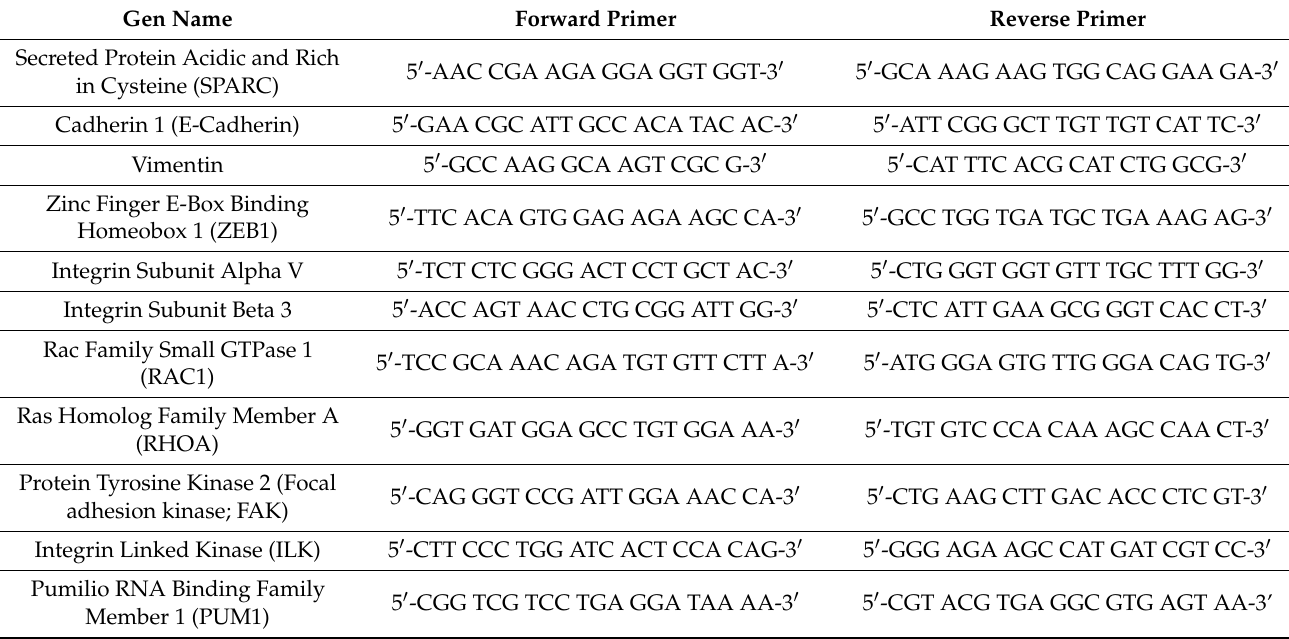
Table 3. Sequence of oligonucleotides used as primers for the